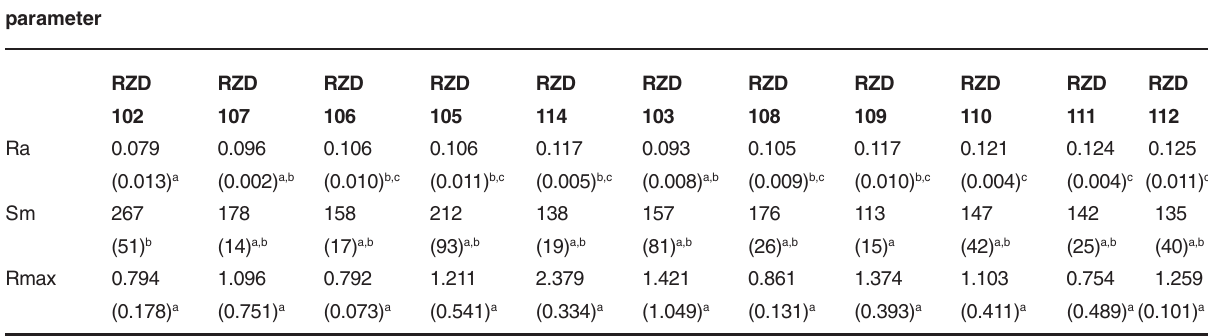
*Superscript letters indicate homogenous subsets (within which p>0.05) where comparison has been made with respect to different composite series. J Appl Oral